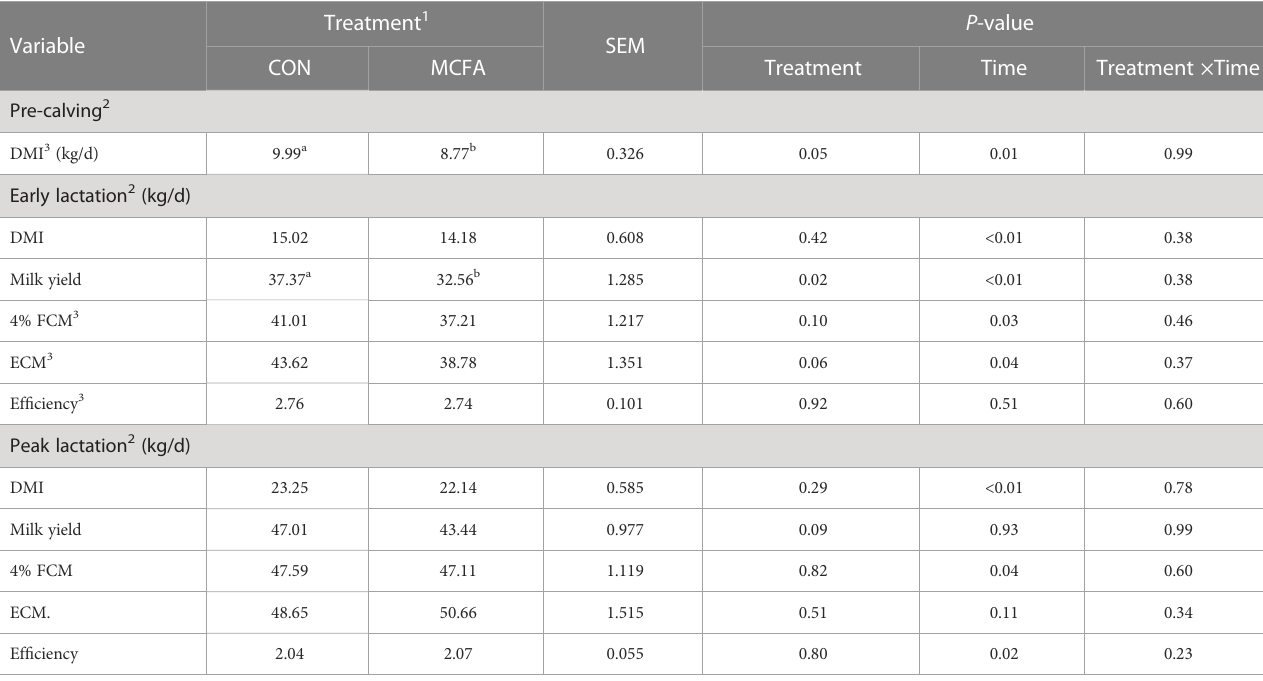
TABLE 2 Effects of feeding medium chain fatty acid on the performance of pre-calving, early lactation, and peak lactation cows 2 .